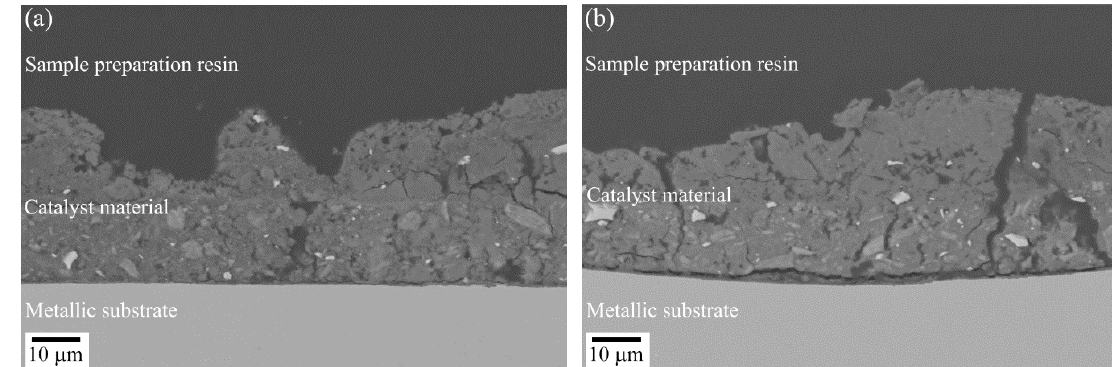
Figure 1. The cross-sectional SEM image of the diesel oxidation catalyst, ( a ) the inlet part of the vehicle-aged catalyst and ( b ) the outlet part of the vehicle-aged catalyst.